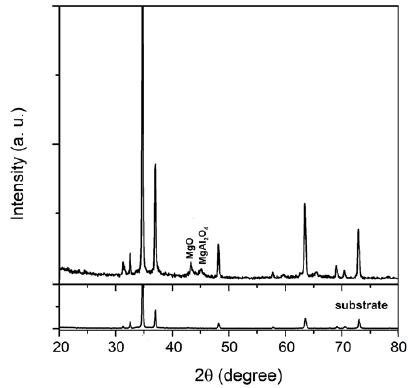
Figure 2. XRD pattern of MgAl coating.